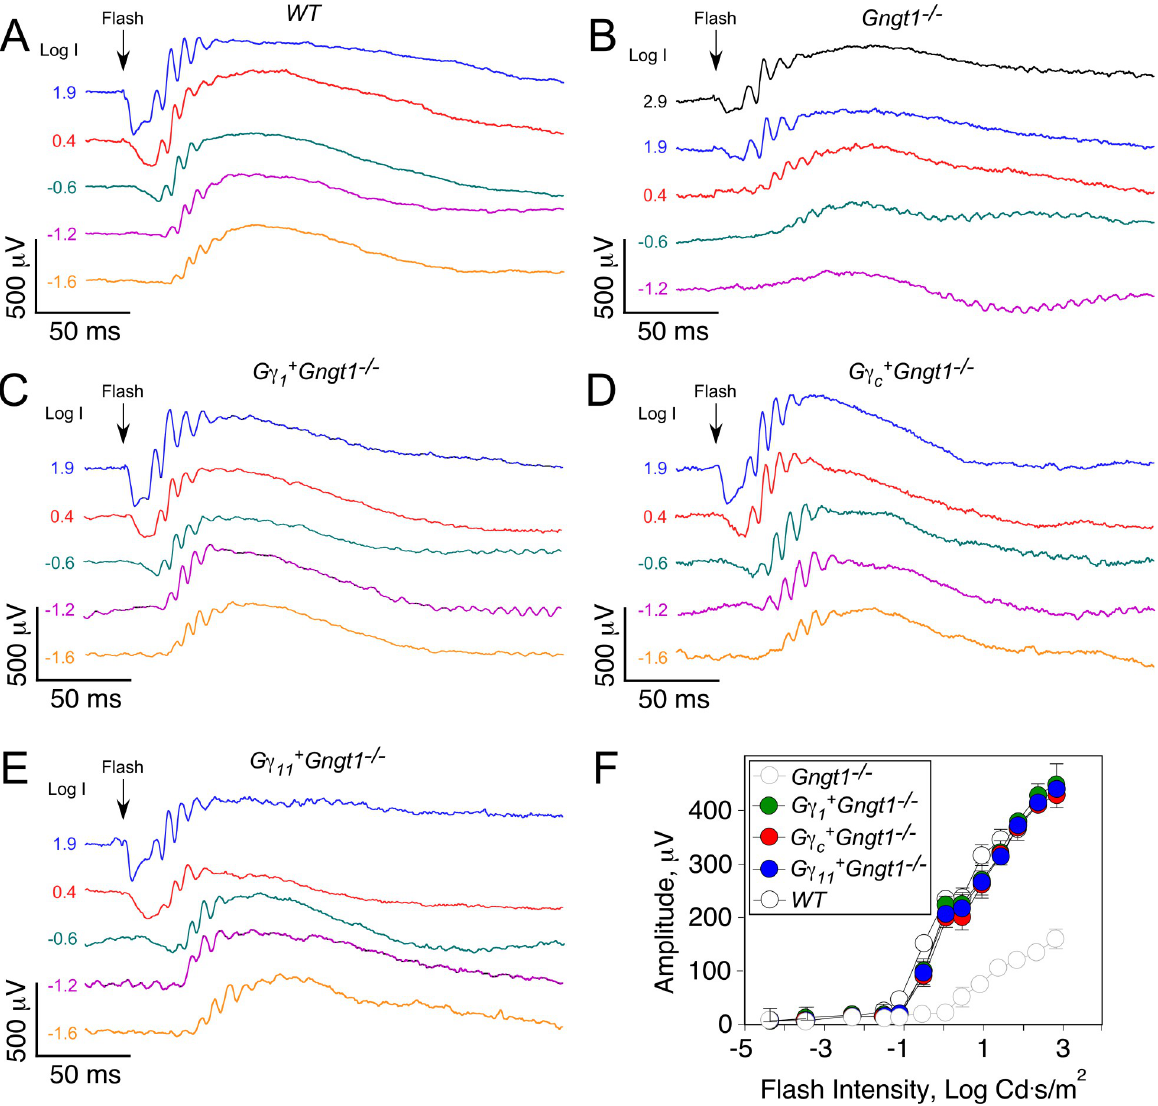
Fig 5. Families of in vivo ERG responses from wild type (A) , Gngt1 -/- (B) , G γ 1+ Gngt1 -/- (C) , G γ c+ Gngt1 -/- (D) , and G γ 11+ Gngt1 -/- (E) mice. Waveforms are color coded according to the white flash of indicated intensity. ( E ) Averaged scotopic in vivo ERG intensity-response functions (mean ± SEM) for wild type (n = 3), Gngt1 -/- (n = 3), G γ 1+ Gngt1 -/- (n = 3), G γ c+ Gngt1 -/- (n = 3), and G γ 11+ Gngt1 -/- (n = 3) mouse lines.